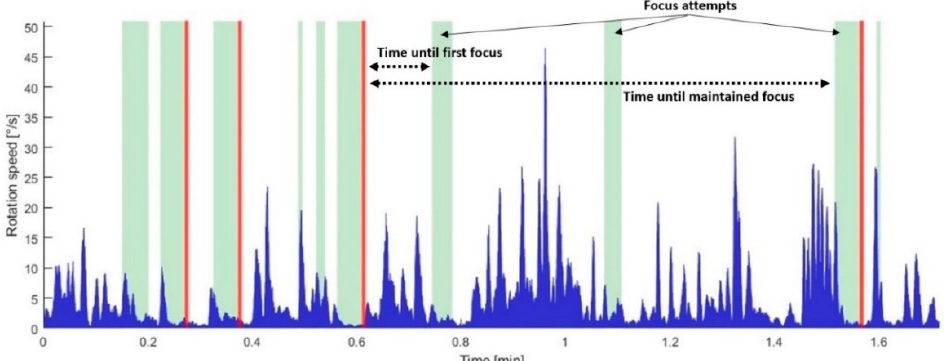
Figure 8. Gaze motion data of a single user in the third test. It includes rotation speed of VES-PVAS FoV (blue): “element focused” (green bars) and “element moved” events (red bars).